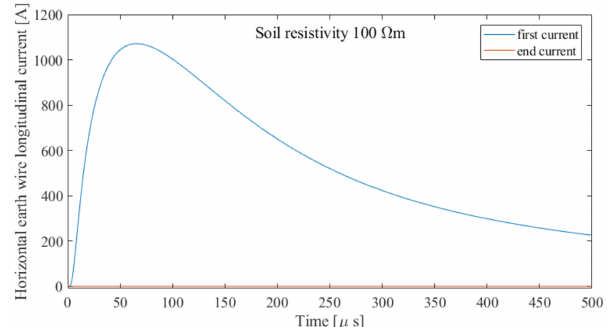
Figure 8. Current time profiles of the copper rope. The distance between the HV/MV station and the MV/LV substation is set equal to 500 m (soil resistivity 100 Ω · m).